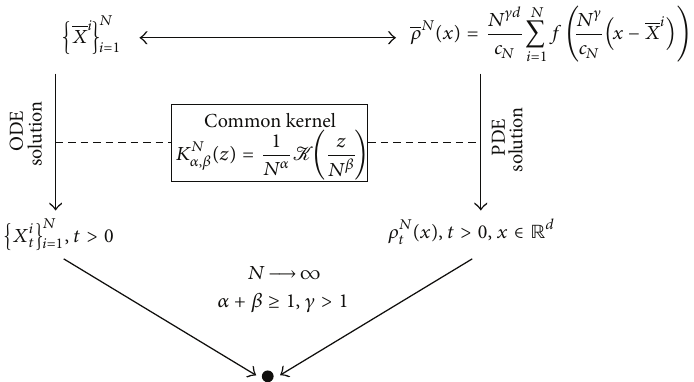
Figure 8: A schematic illustration of the result of the paper. The ODE and PDE solutions approach each other for 𝑁 → ∞ under certain conditions on the scaling of the interactions and of the initial